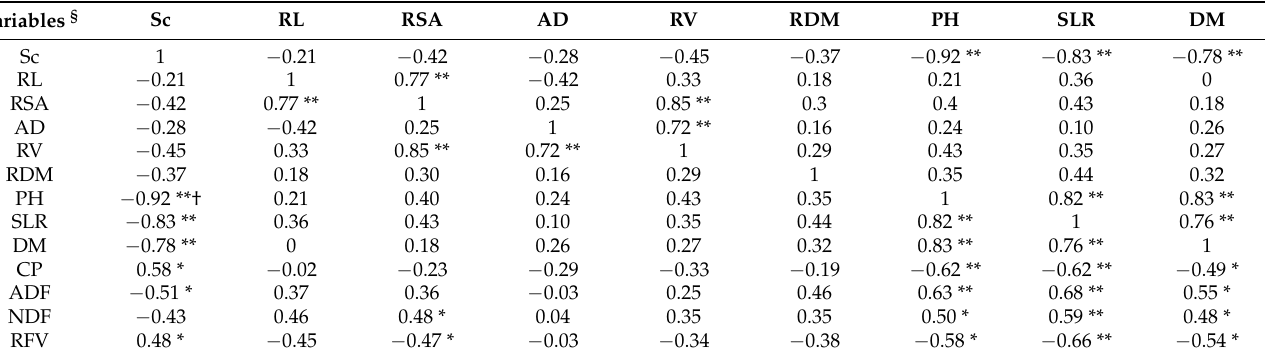
Table 4. Pearson’s correlations coefficients between soil salt content with root and aboveground growth parameters in